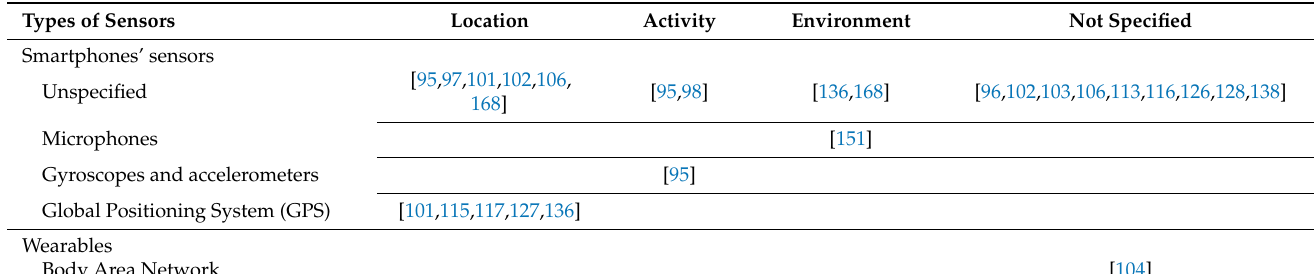
Table 3. Types of data acquired by personal